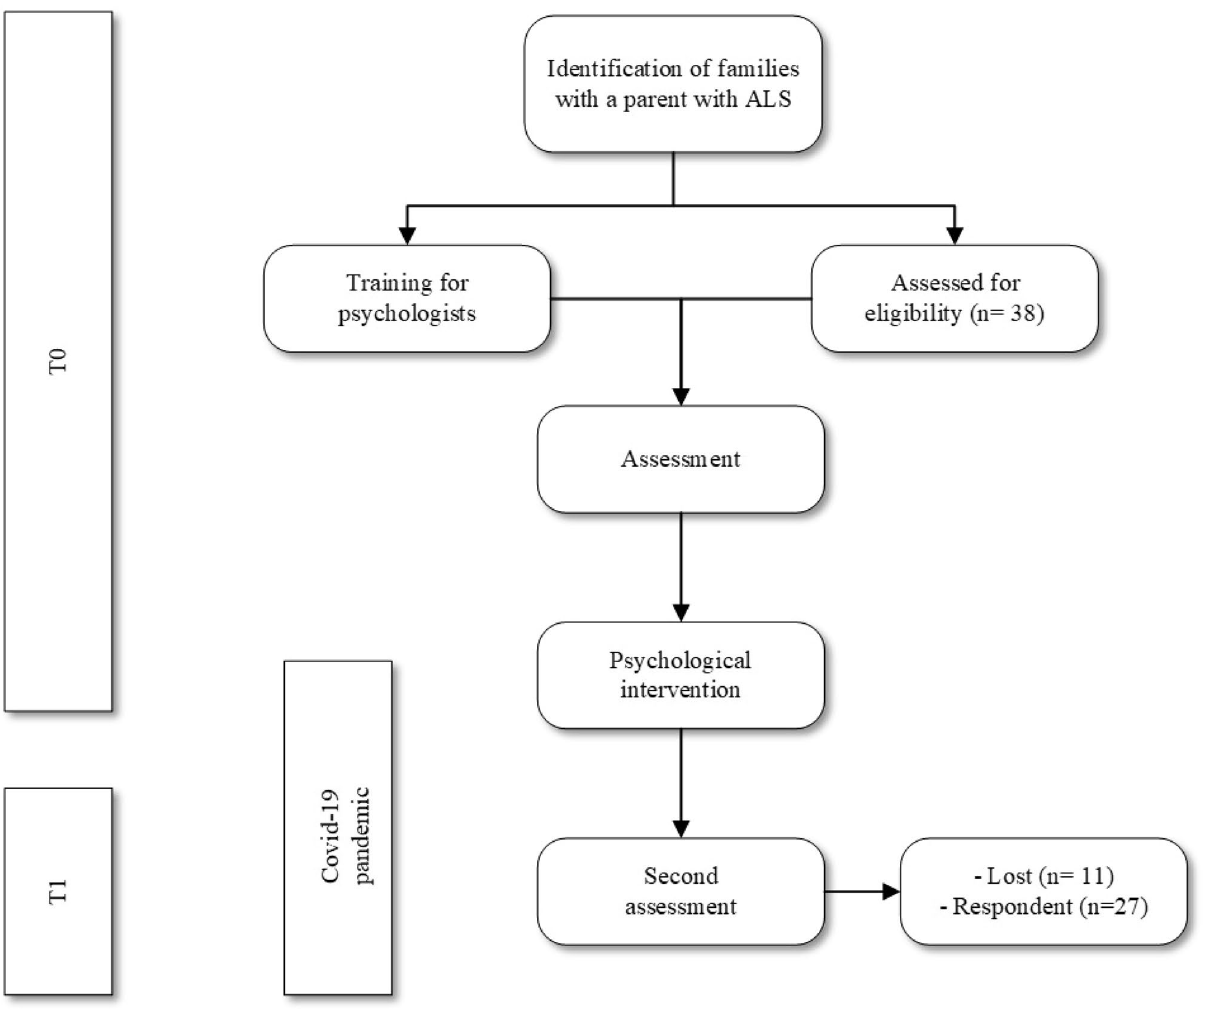
Figure 1. Flow chart of the study